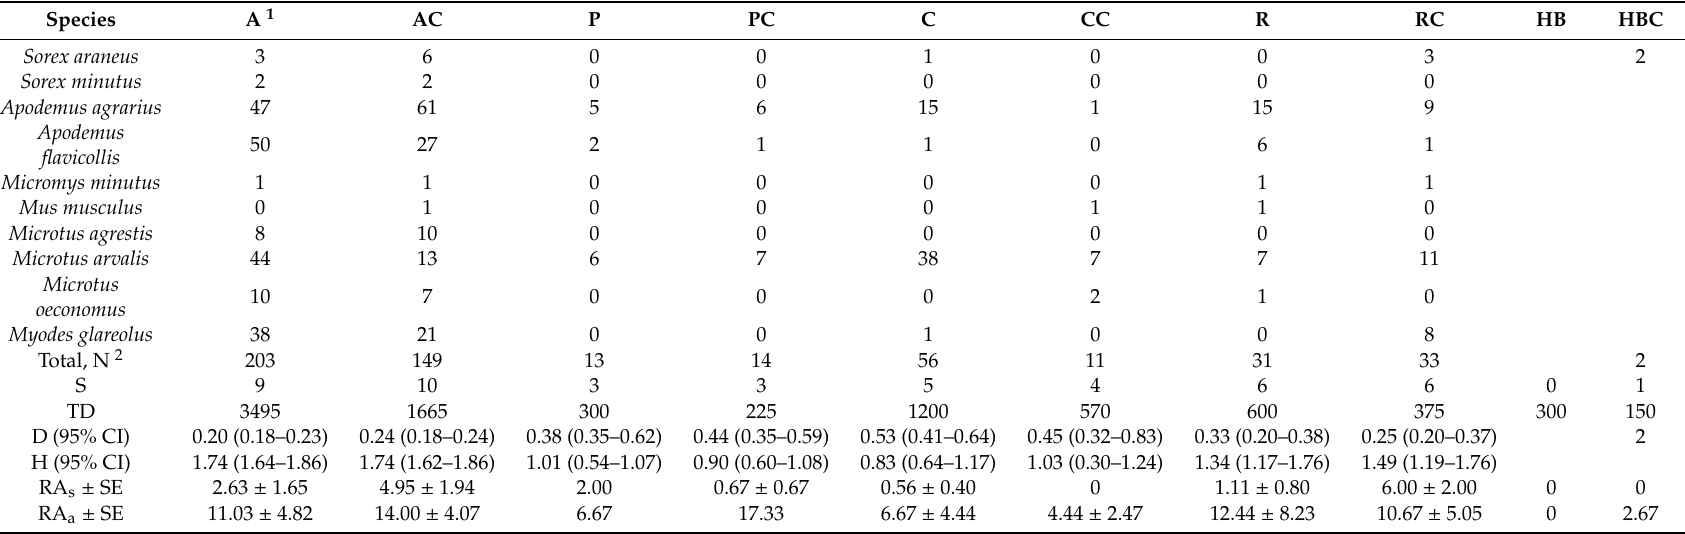
Table 3. Small mammal diversity, numbers trapped, and relative abundance (recalculated to 100 traps per day) in commercial orchards, berry plantations, and control